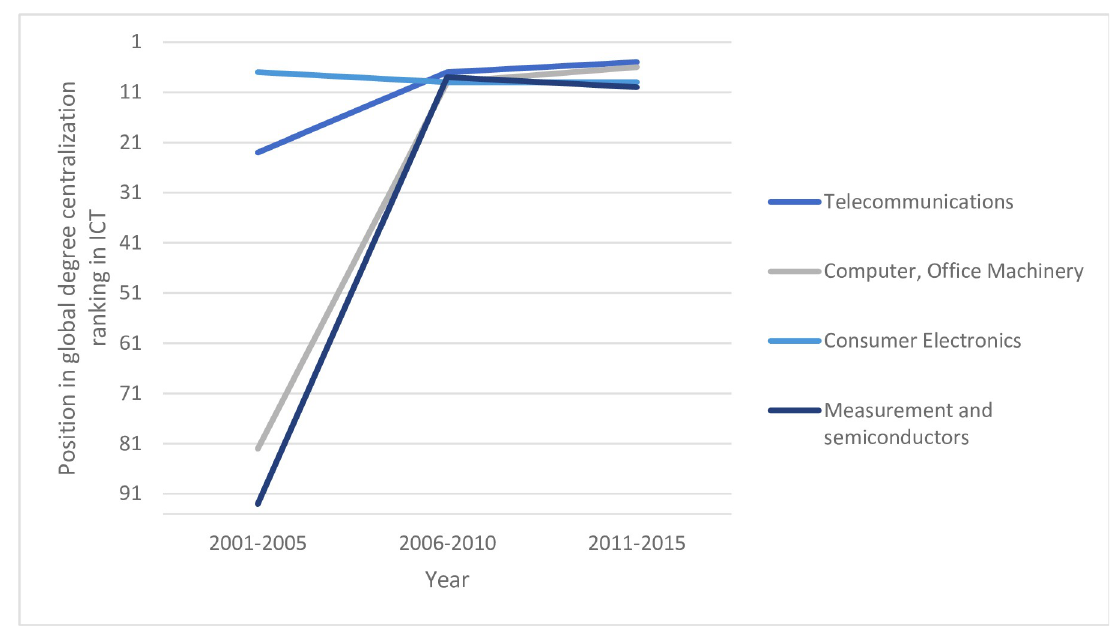
Fig 2. China’s global ranking of degree centrality in ICT (2001–2015).